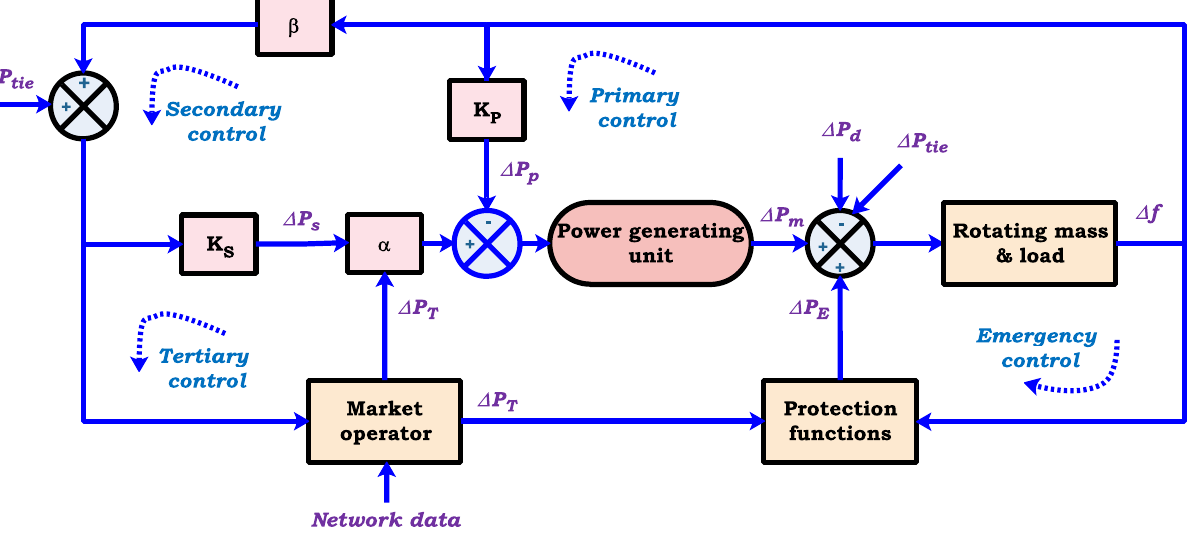
Figure 5. The conceptual block diagram of frequency